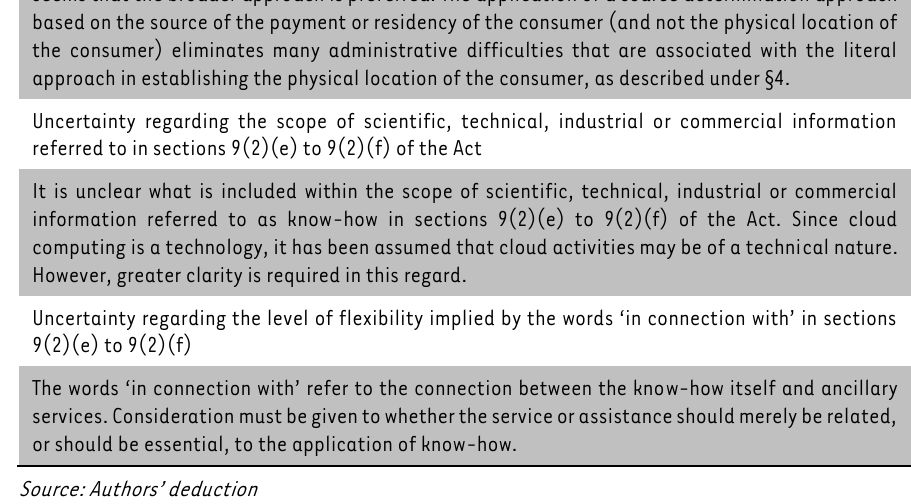
TABLE 3: Issues identified relating to source determination of royalties and income from know-